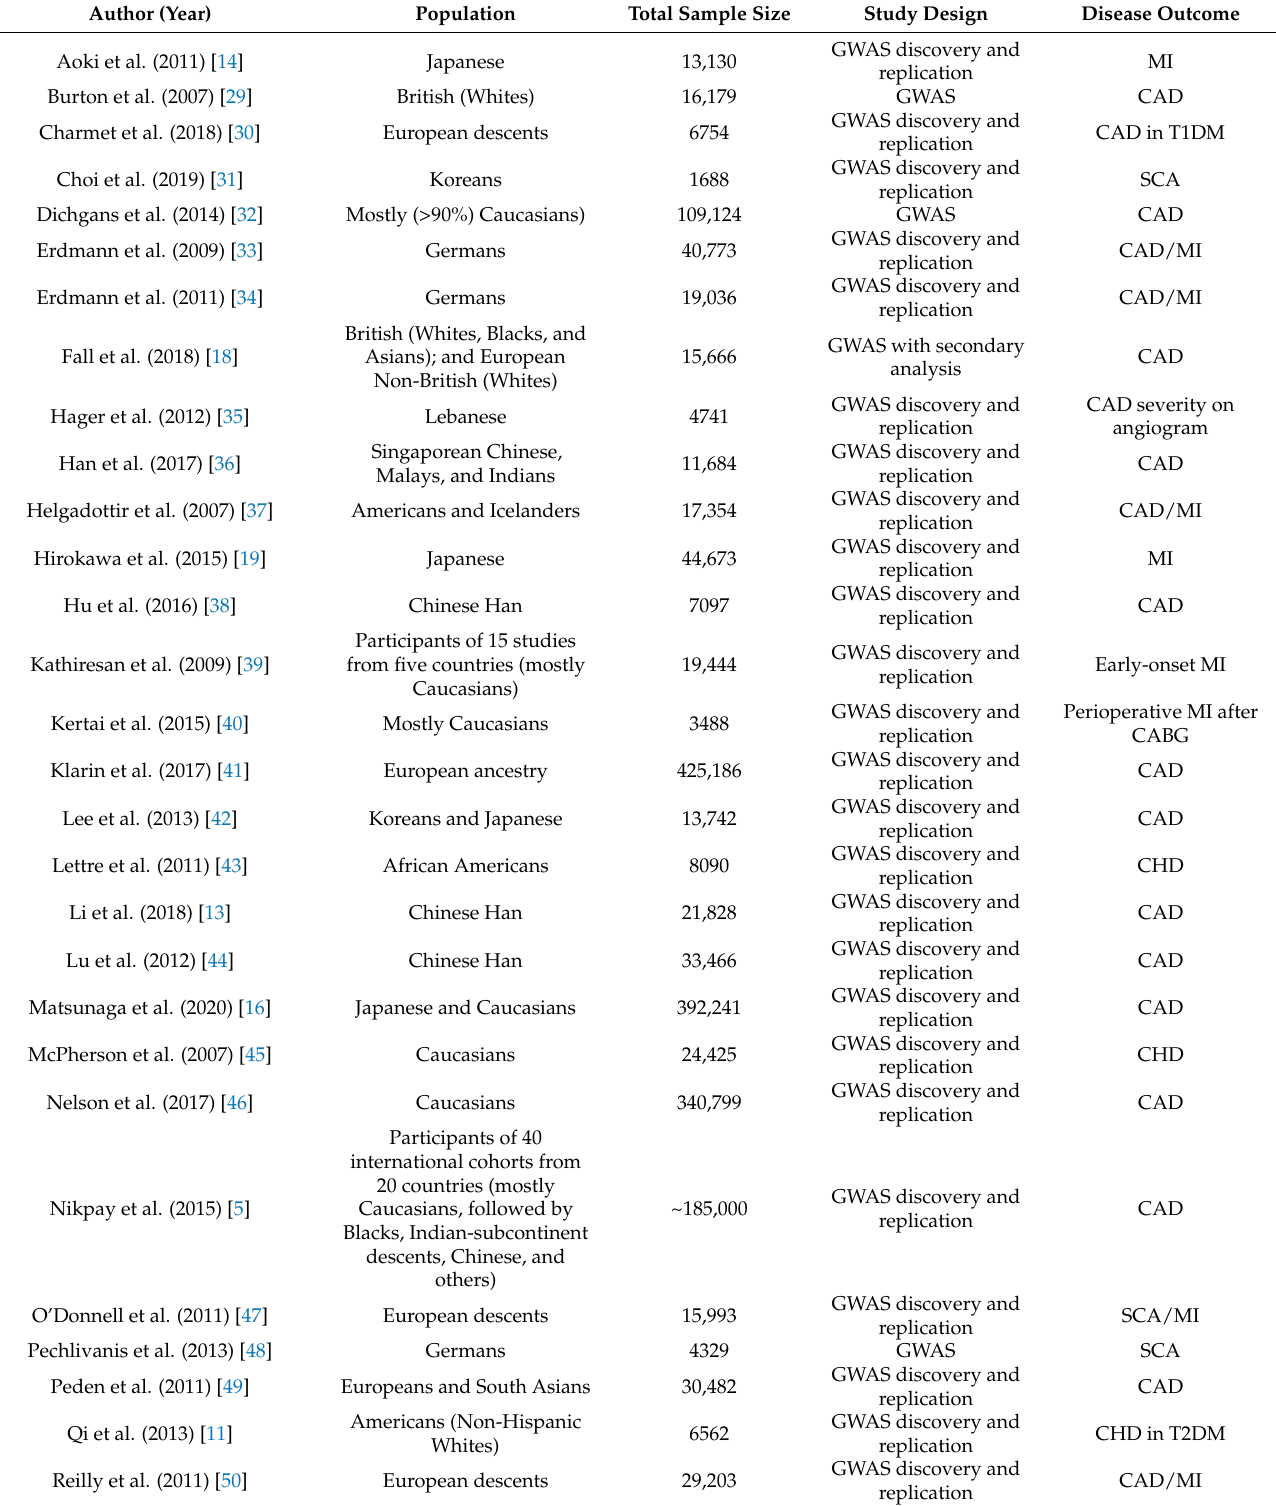
Table 1. The list of included publications sorted alphabetically according to the authors’